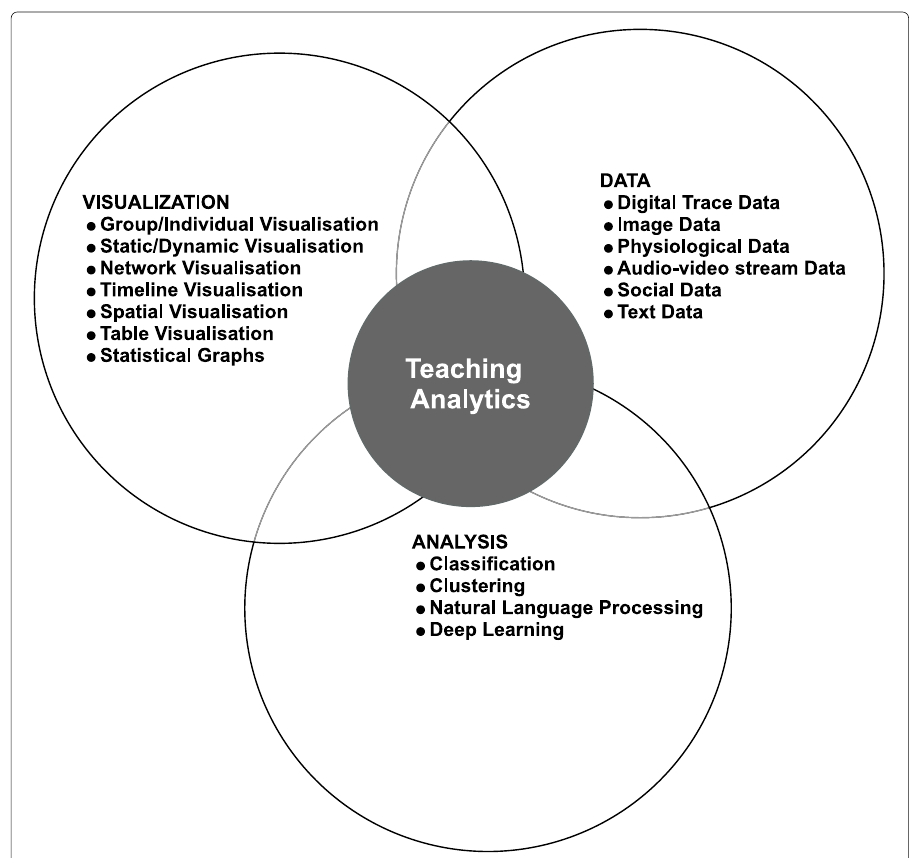
Fig. 6 Dimensions of TA. Illustration of TA based on the